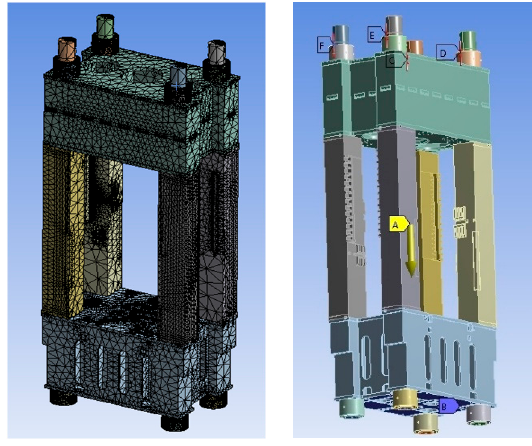
Figure 6. The simulation model of a hydraulic press.